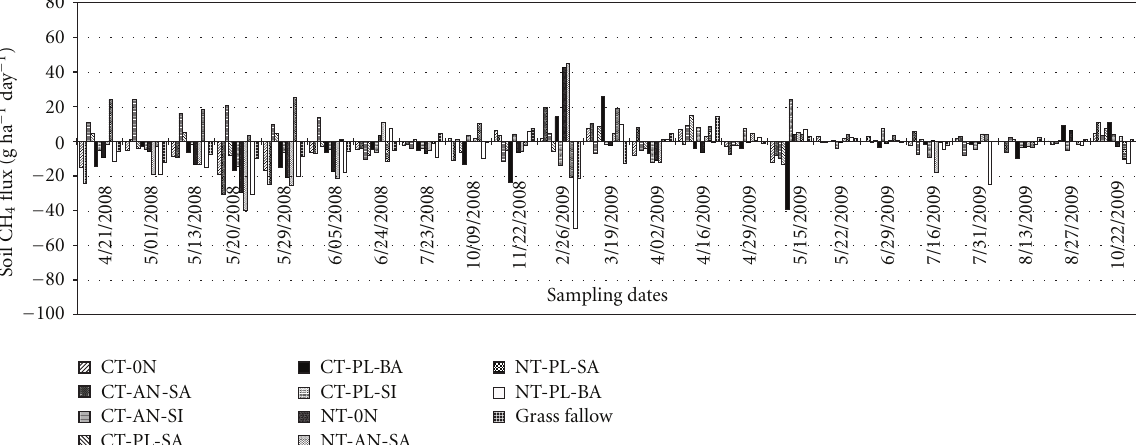
Figure 2: Soil CH 4 fluxes in corn plots receiving ammonium nitrate (AN) and poultry litter (PL) N fertilizers using surface (SA), soil incorporation (SI), and subsurface band (BA) application methods in conventional tillage (CT) and no-tillage (NT), systems, Hazel Green,